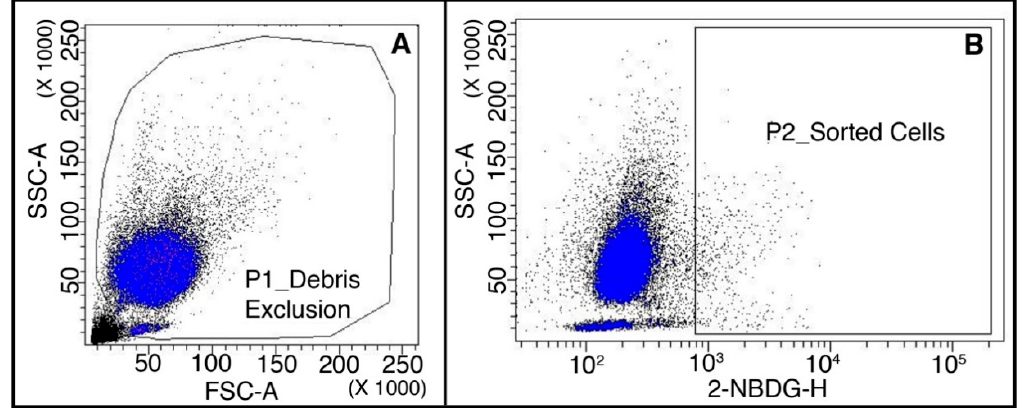
Figure 7. Analysis of a representative patient blood sample. ( A ) Dot-plot showing the morphological parameters Forward- and Side-Scatters; P1 gate selects cells and discards debris; ( B ) dot-plot showing the glucose uptake of P1-gated cells; P2 gate selects cells with the highest intensity of 2-NBDG fluorescence according to the “2.5 SD” threshold.